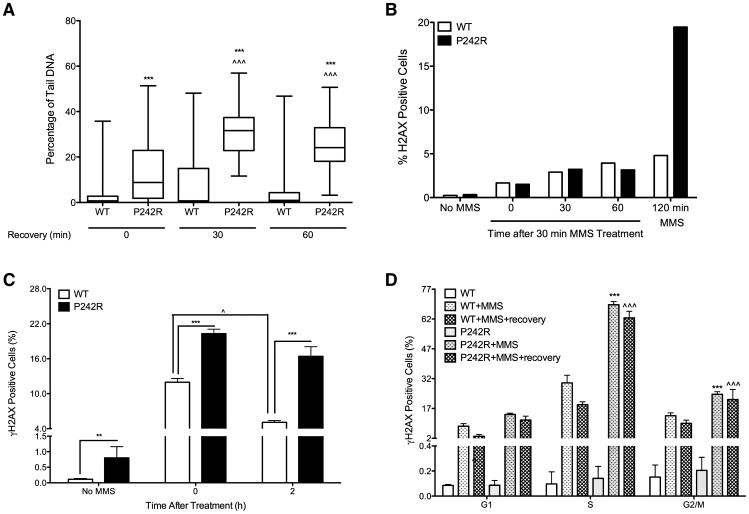
Accumulation of BER intermediates in MCF10A cells expressing P242R Pol β.A. MCF10A pools expressing WT or P242R Pol β were treated with 2 mM MMS for 30 minutes and allowed to recover for 0, 30, or 60 min and single-strand breaks (SSBs) were analyzed by comet assay. The percentage of tail DNA is plotted on the Y-axis. B. MCF10A pools expressing WT or P242R Pol β were treated with 2 mM MMS for 30 min and allowed to recover for 0, 30, or 60 min, stained with γH2AX antibody, and analyzed by flow cytometry. Cells were treated for 120 min as a positive control. C–D. MCF10A pools expressing WT or P242R Pol β were treated with 2 mM MMS for 2 h and allowed to recover for 0 or 2 hours. Cells were stained with γH2AX antibody and propidium iodide to assess the levels of double-strand breaks (DSBs) and the cell cycle phase, respectively, and analyzed by flow cytometry. Data are plotted as the mean ± SEM (n = 3). A and C. ** and *** denote p<0.01 and 0.001, respectively. ∧ denotes p<0.05 comparing 0 vs 2 h recovery within each cell line. ∧∧∧ denotes p<0.001 comparing 30 or 60 min recovery to 0 recovery. D. *** denotes p<0.001 comparing WT+MMS to P242R+MMS in each phase of the cell cycle. ∧ and ∧∧∧ denote p<0.05 and 0.001, respectively, comparing WT+MMS+recovery to P242R+MMS+recovery in each phase of the cell cycle.